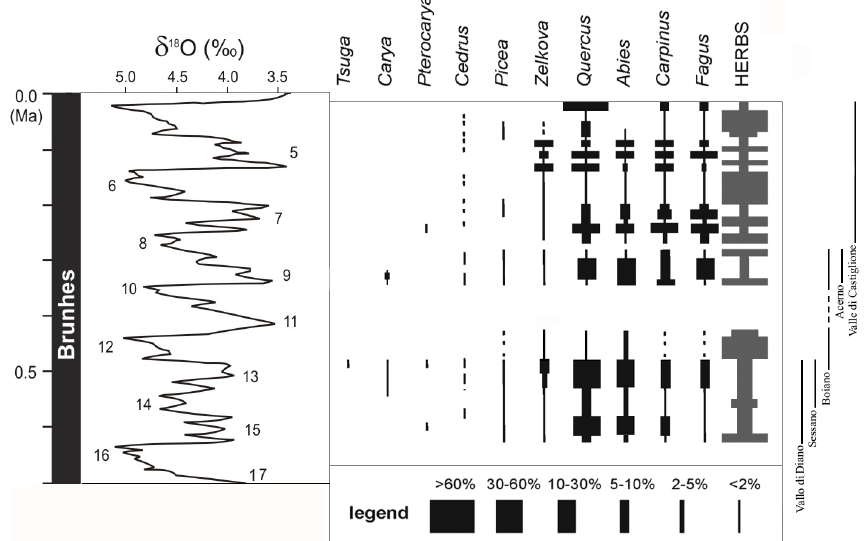
Figure 4. Synthesized diagram of the local palynological studies, presenting the dynamics of the main taxa for the studied period, compiled